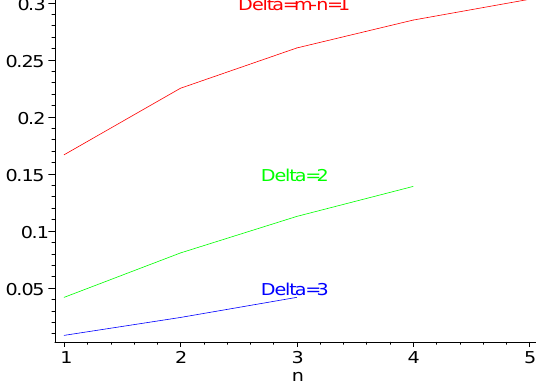
Figure 4. Value of P values of n